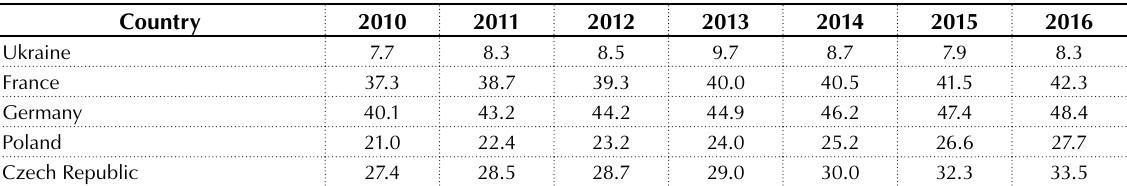
Table 3. GDP per capita according to purchasing power parity in Ukraine compared to EU countries, ths USD